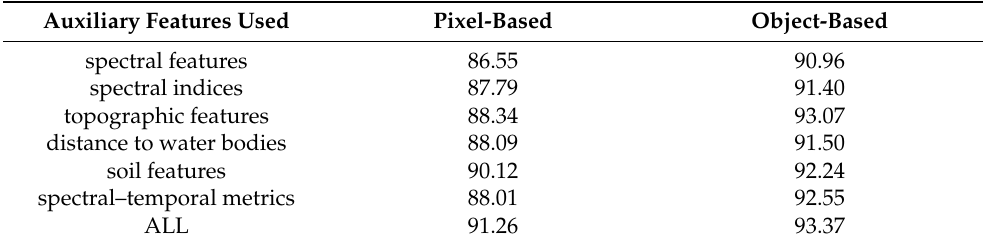
Table 7. Overall accuracy results of the Classification and Regression Trees (CART)